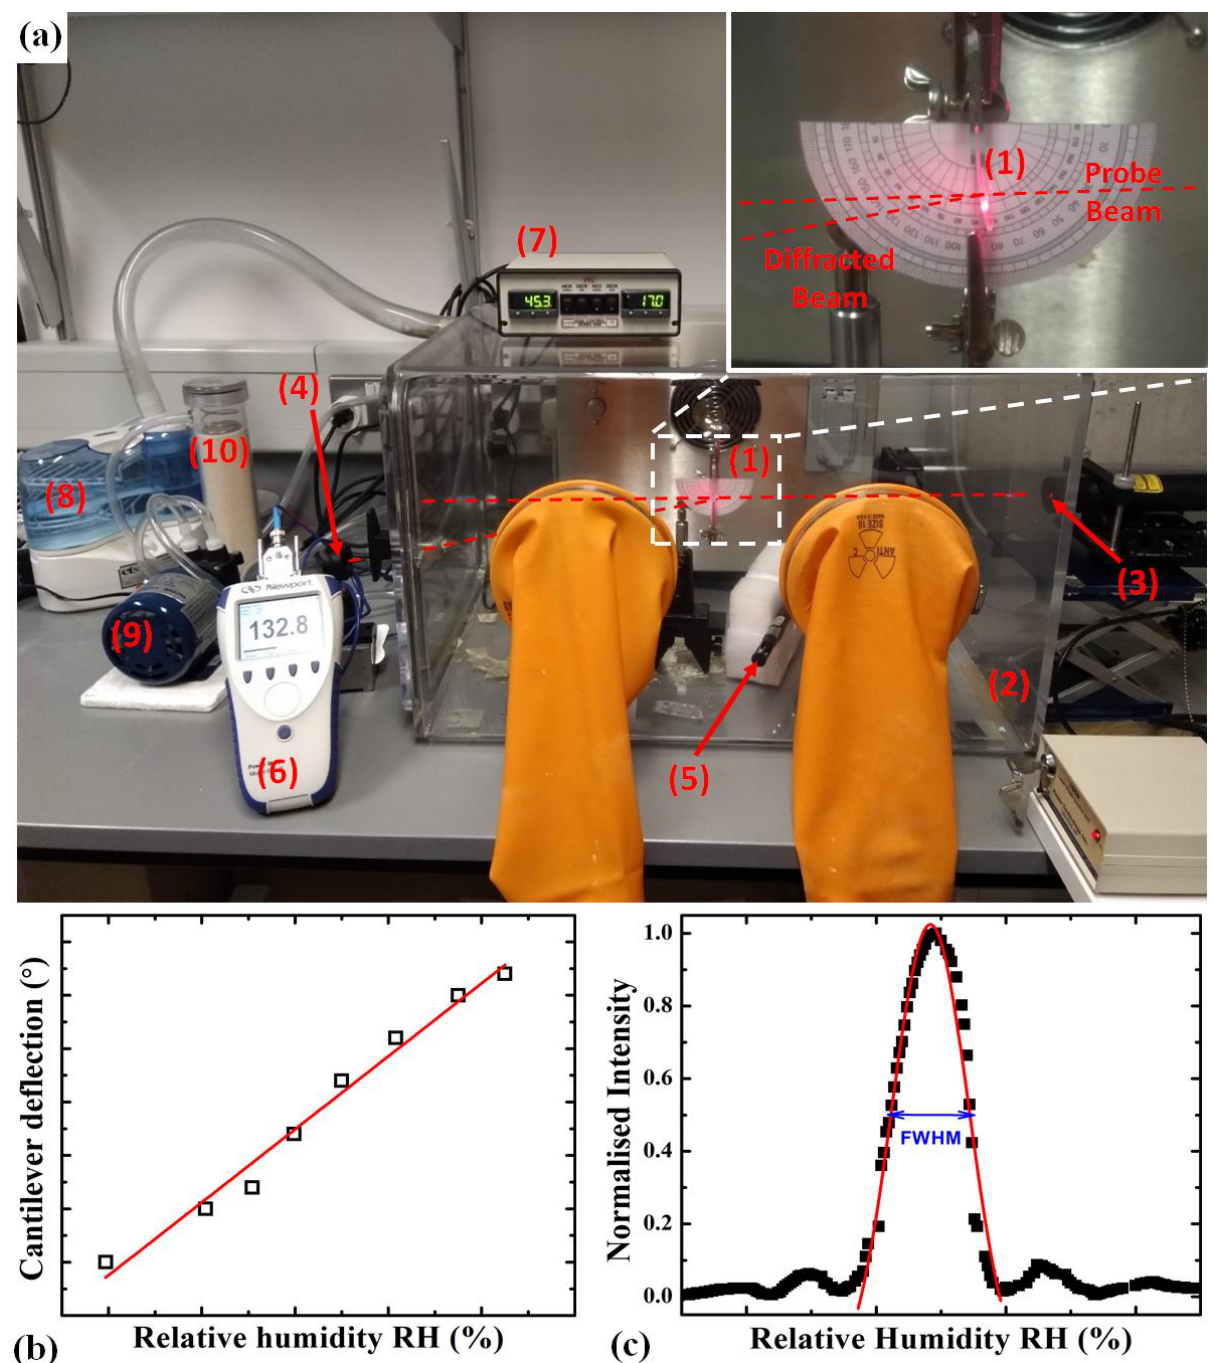
Figure 1. ( a ) Photograph of the experimental setup: the cantilever sensor (1) placed within the humidity and temperature- controlled environmental chamber (2). A probe beam is sent from the laser diode (3), the diffracted beam intensity is measured by the photo-detector (4) connected to the power meter (5). The humidity and the temperature in the chamber were monitored through the sensor (6) and controlled with the microcontroller (7) with the help of the humidifier (8), the pump (9) and the desiccant cartridge (10). Inset: A photograph of the hybrid photopolymer polydimethylsiloxane (PDMS) cantilever sensor system. The typical paths of the probe and diffracted beams are schematically presented as a guide to the eye only. ( b ) Typical cantilever deflection that can be visually evaluated both as angular (in ◦ ) deflection as the humidity changes. The angular deflection was then transformed into linear deflection (in mm). ( c ) Typical Bragg diffraction selectivity curve measured as the humidity was varied. A typical Gaussian fitting of the main peak and the full-width half-maximum (FWHM) position are also